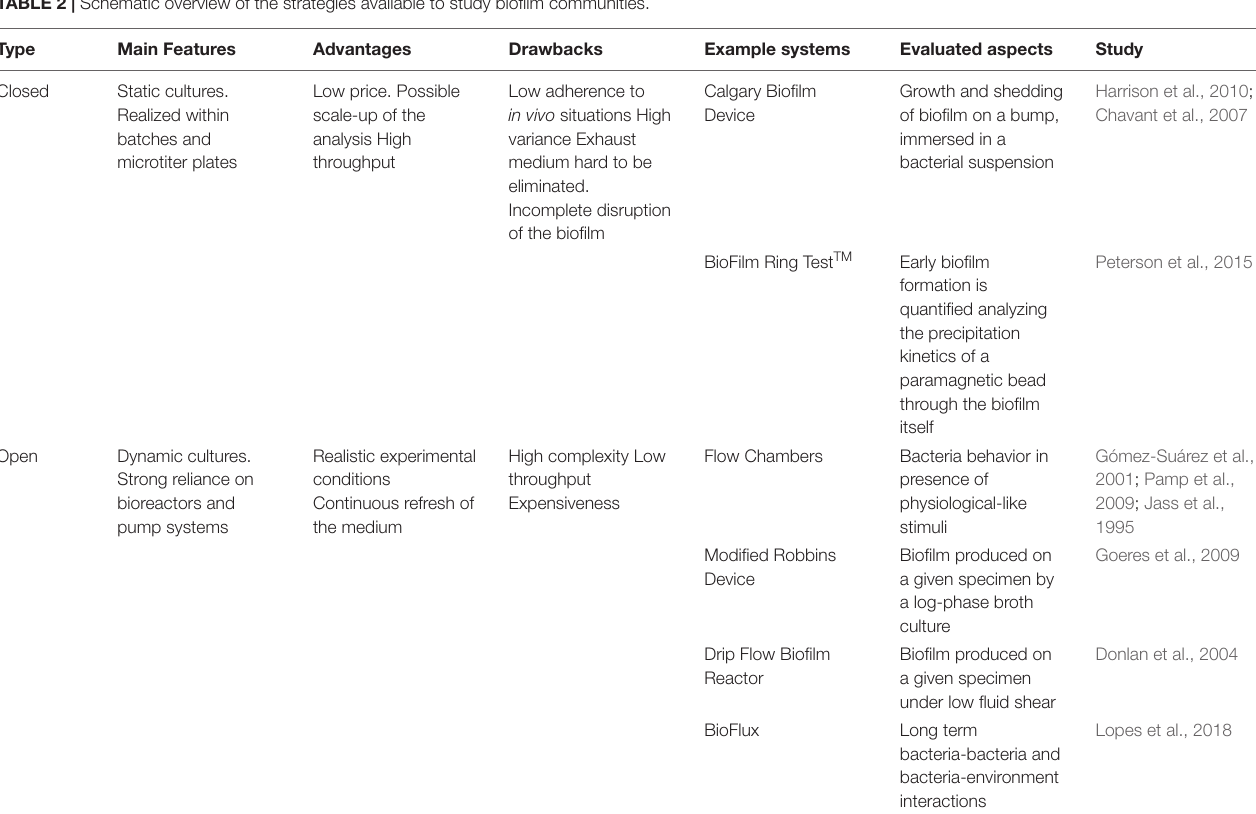
TABLE 2 | Schematic overview of the strategies available to study biofilm